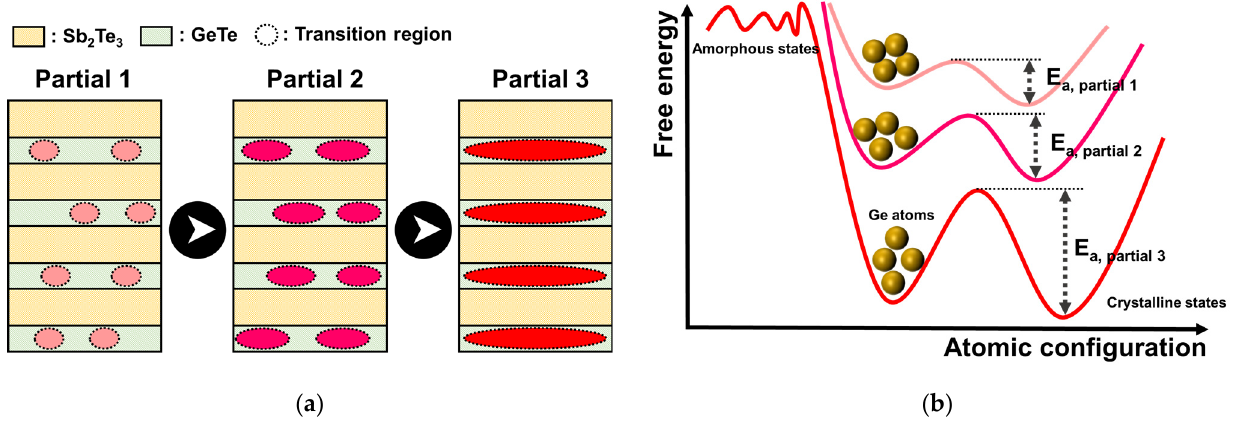
Figure 4. ( a ) Partial model of the GeTe/Sb 2 Te 3 iPCM. ( b ) The schematic interaction potential for Ge atomic switching in a GeTe/Sb 2 Te 3 iPCM.